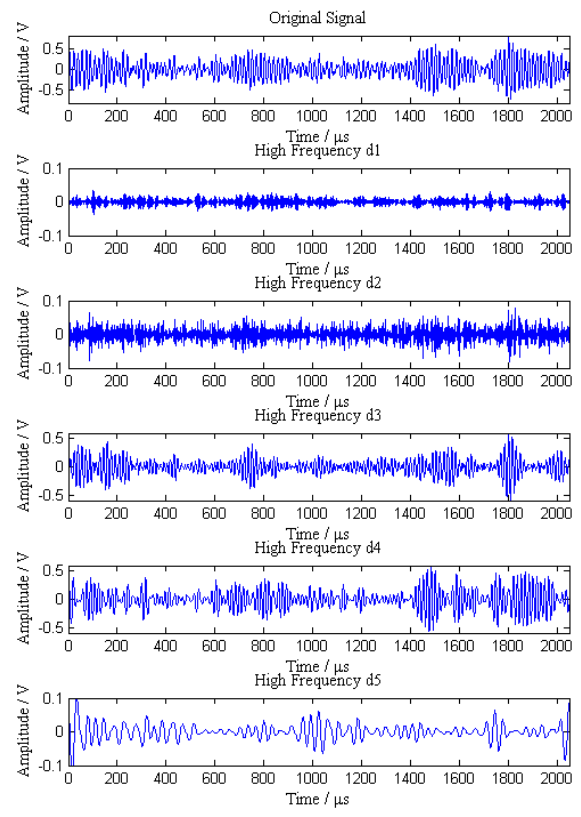
Figure 9. Signal decomposition of node 3.